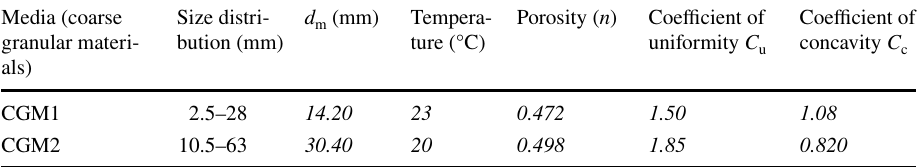
Table 1 General characteristics of the tested granular media